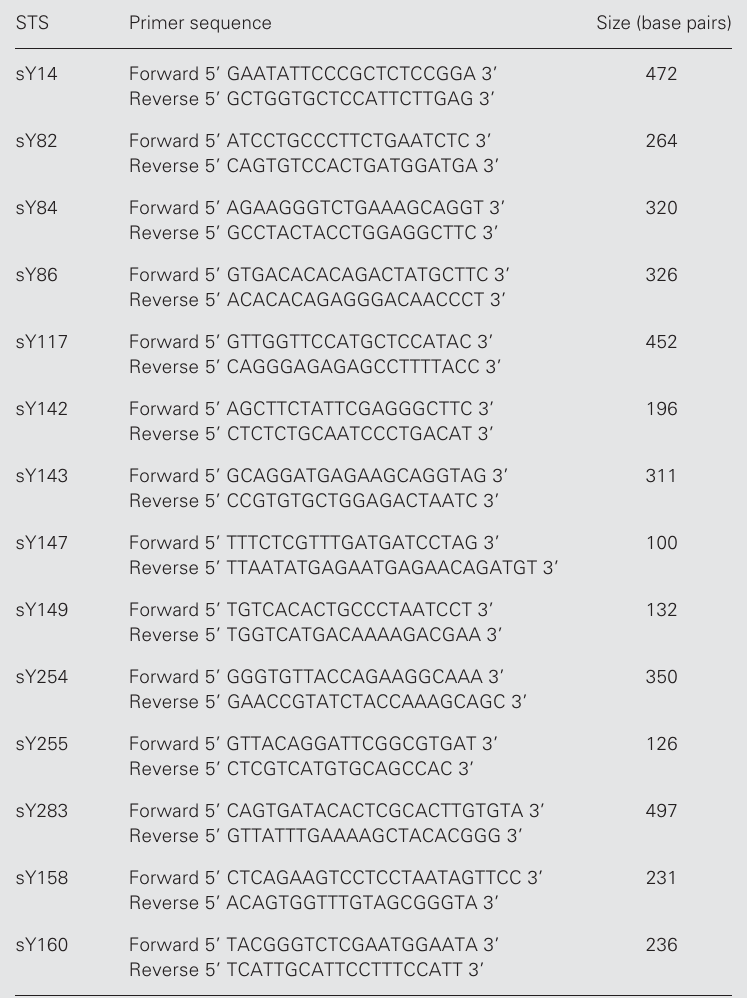
Table 1. Sequence-tagged sites (STS) and primer sequences used for Y chromosome microdeletion